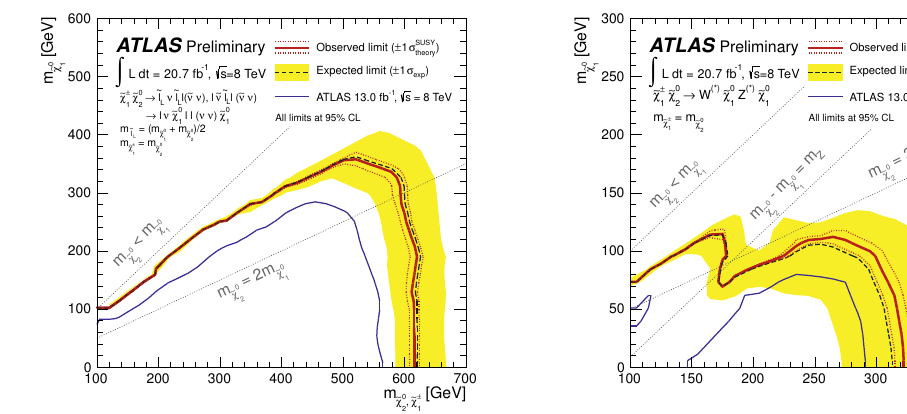
Figure 17: Observed and expected 95% CL limit contours for chargino and neutralino pro- duction in the simplified model scenario with decay via sleptons. [12]